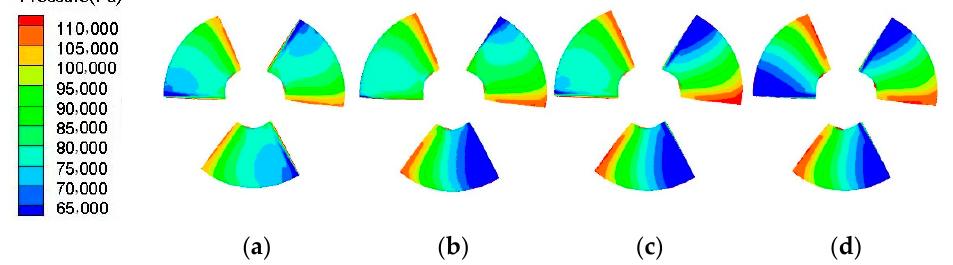
Figure 14. Pressure distribution on the back of the blade of different schemes ( Q = Q des ). ( a ) Scheme I.